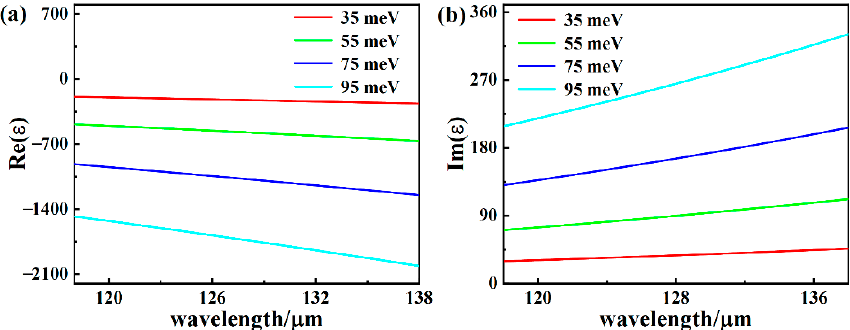
Figure 2. The real ( a ) and imaginary ( b ) parts of the permittivity of the BDS material.